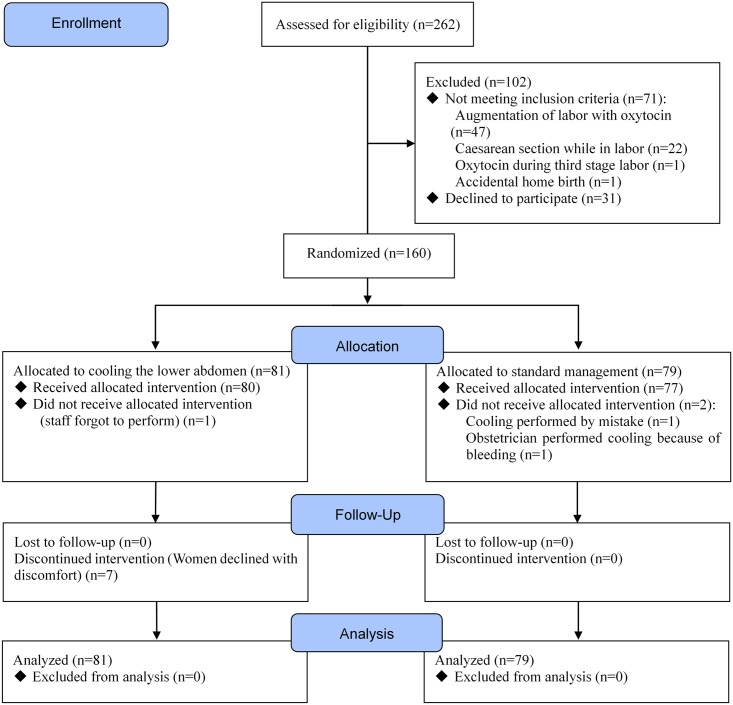
Trial flow diagram.